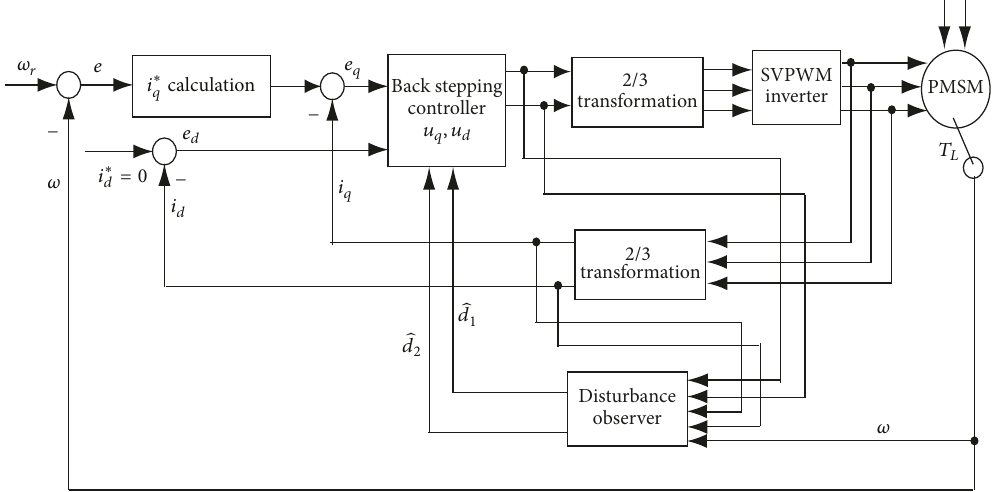
Figure 1: Block diagram of the proposed DOB backstepping PMSM control system.